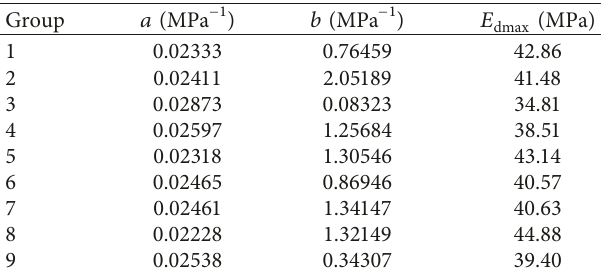
Table 5: Maximus dynamic elastic modulus and test parameters under different test conditions.